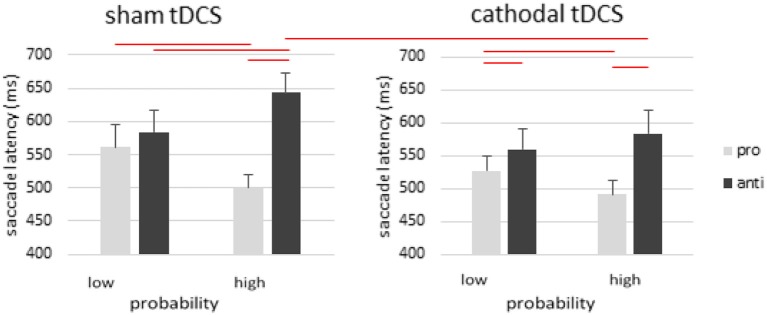
Effects of cathodal tDCS on rFEF. Cathodal tDCS facilitated pro- and anti-saccades in the low probability condition, but more so for the pro- than antisaccades, thereby showing a significant antisaccade cost in the low probability condition after tDCS. Importantly, cathodal tDCS produced faster antisaccade away from the high probability location such that the antisaccade cost is actually significantly reduced in the high probability condition after cathodal tDCS. Error bars represent standard error of the mean.